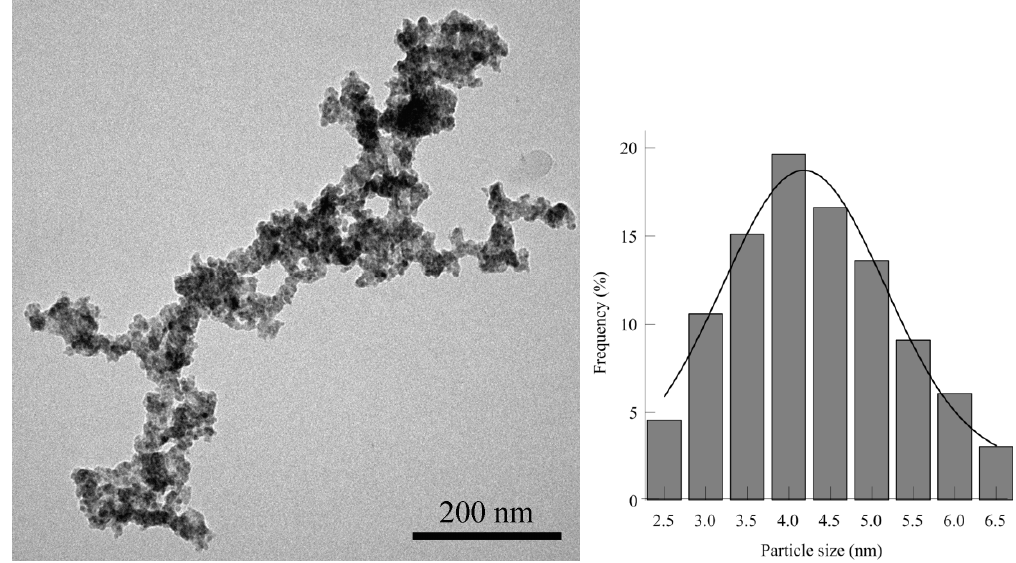
Figure 3. TEM image and particle size distribution histogram of ZnS nanoparticles.